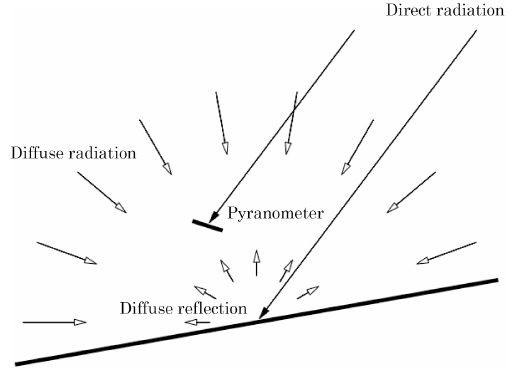
Figure 5. Isotropic reflection from a tilted slope with an inclined